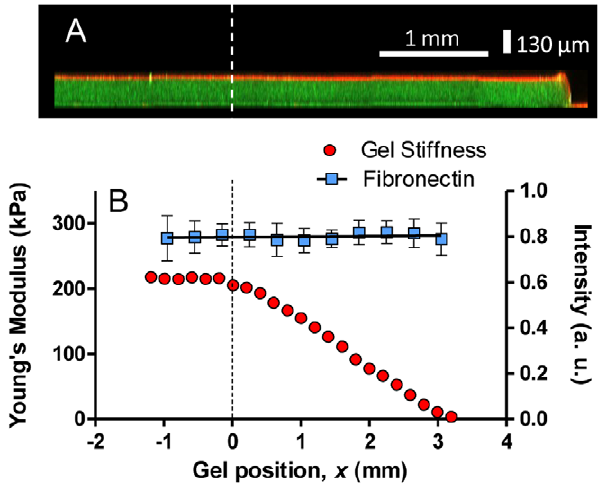
Figure 4. Fibronectin density is independent of gel stiffness. (A) Confocal cross-sectional fluorescence image of a stiffness gradient hydrogel confirms that the protein functionalization (fibronectin, stained in red) is confined to the top surface of the hydrogel and that the hydrogel (marked with embedded green fluorescent beads) thickness is constant across the different stiffness areas. Dashed line indicates initial position of the mask. The left edge of the hydrogel has been truncated. (B) Fluorescence intensity profile along a gradient hydrogel coated with fibronectin and labeled with antibody (squares) is shown together with spatial variation of hydrogel elasticity (circles). Error bars represent SE of 3 replicates.